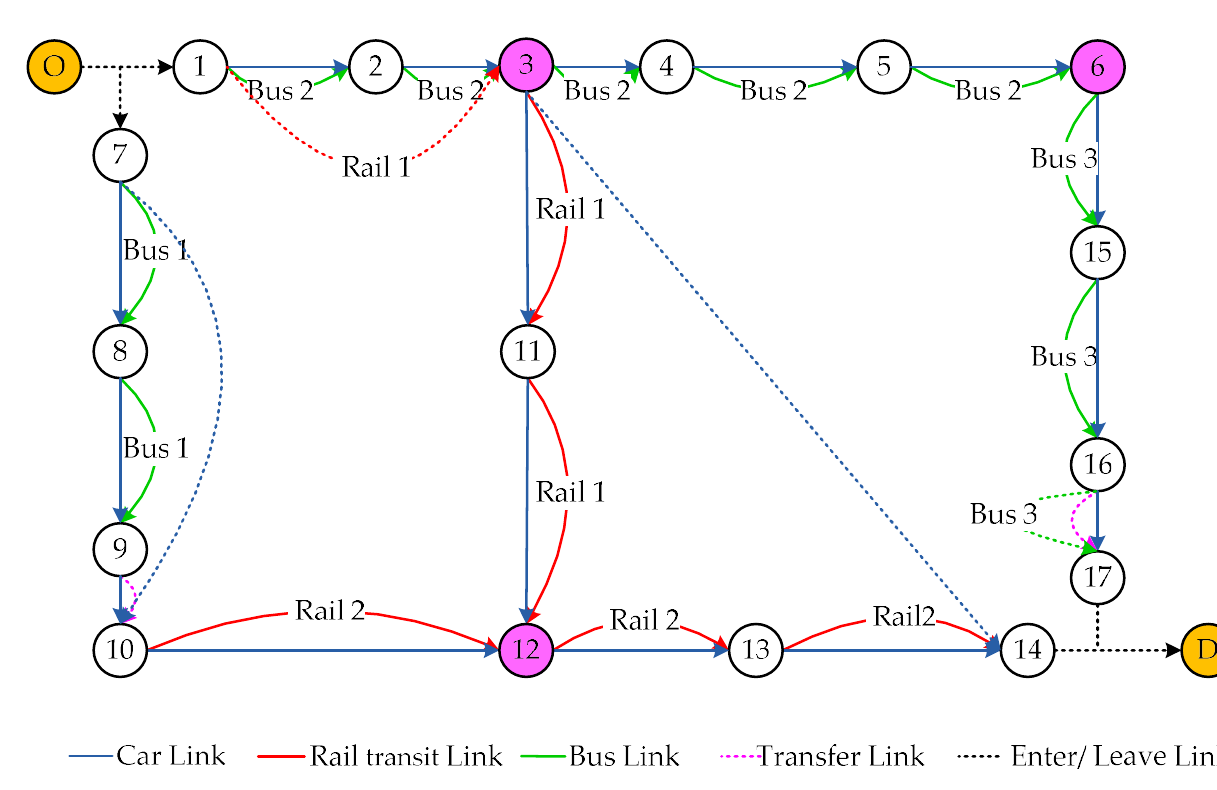
Figure 12. The optimization schemes on a simple multimodal network.